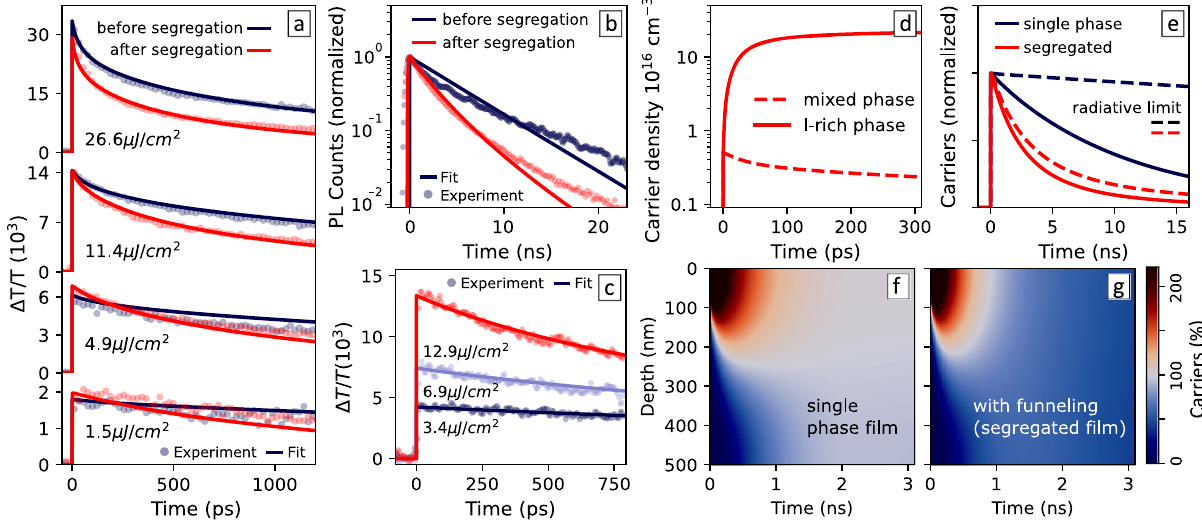
Fig. 4 Impact of phase segregation on the charge-carrier dynamics. a OPTP transients of an MAPb(I 0.5 Br 0.5 ) 3 thin fi lm at various photoexcitation fl uences, before and after phase segregation. b PL dynamics of 670 nm emission before segregation (dark blue) and 750nm after segregation (red), at fl uence 50 nJ/cm 2 . c OPTP transients of an MAPb(I fi lm after segregation, with direct photoexcitation of the I-rich domains at 720 nm. In a – c , 0.5 Br 0.5 ) 3 thin dots are experimental data and solid lines are fi ts to the model described in Supplementary Note 2. d Charge-carrier densities within each phase of the segregated fi lm, extracted from the model described in Supplementary Note 2. e Simulated decay in a single-phase fi lm before segregation (dark blue) and after segregation (red). Dashed lines are dynamics simulated with no trap-assisted recombination ( k 1 = 0). f , g Simulated charge-carrier distribution over time across a 500 nm thick fi lm at the radiative limit ( k 1 = 0) before and after phase segregation. The initial distribution is given by the absorption pro fi le of 400 nm light. The carrier population is normalised by the average initial density so that 100% value is equivalent to the uniform distribution of the photogenerated carriers following diffusion. Values below 100% after reaching a uniform distribution are a result of carrier loss by radiative recombination.